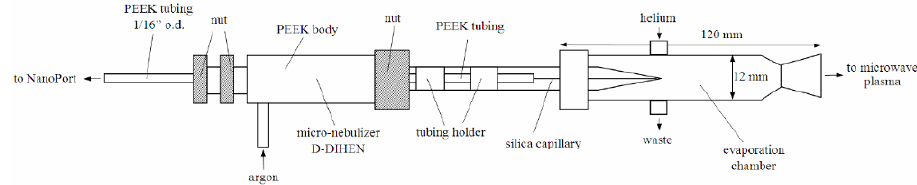
Figure 2. Schematic diagram of the interface micro-nebulizer/mini spray